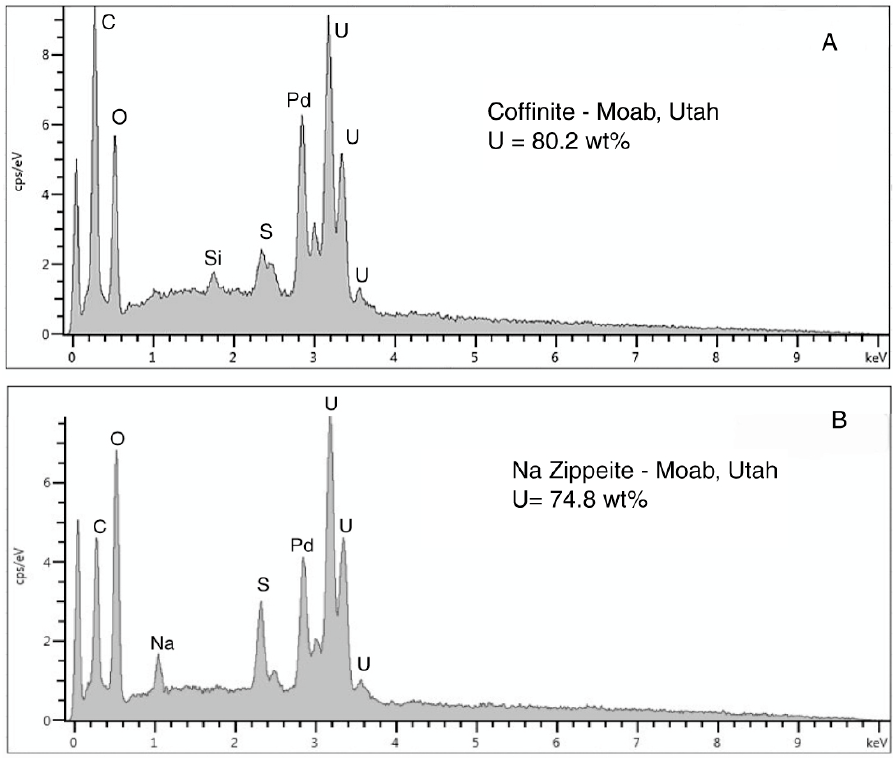
Figure 27. SEM/EDS spectra of the three uranium minerals present in the Moab, Utah specimen. ( A ) Coffinite is the primary uranium mineral, typically occurring in lumina of carbonized wood cells. ( B ) Zippeite appears to be an alteration product that occurs both as surface crusts and within the carbonized wood zone. Na-Zippeite is associated with gypsum crystal clusters that are present as surface crusts.